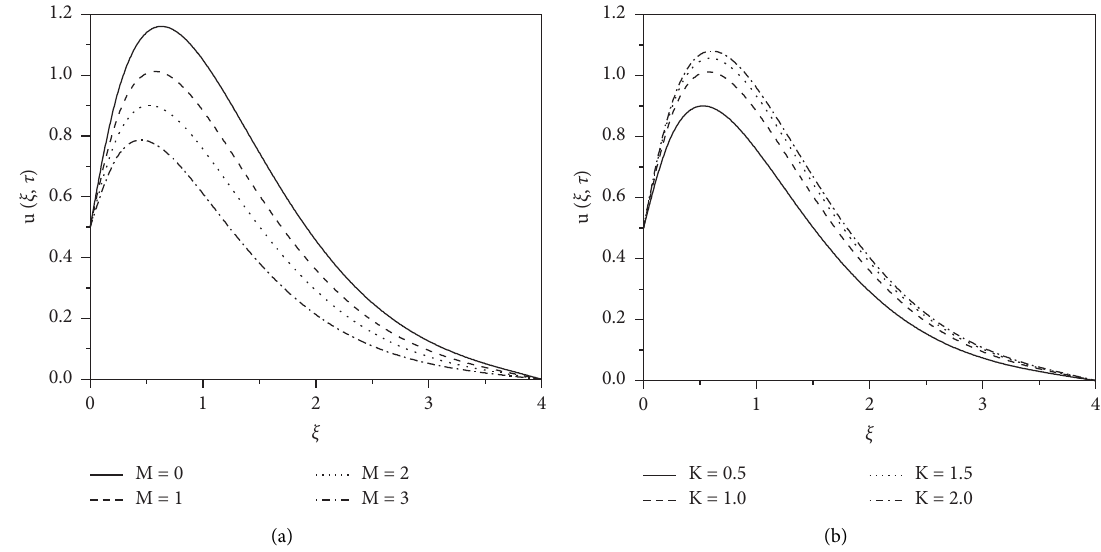
Figure 10: Variation of velocity u ( ξ , τ ) against ξ for various values of (a) M and (b) K .